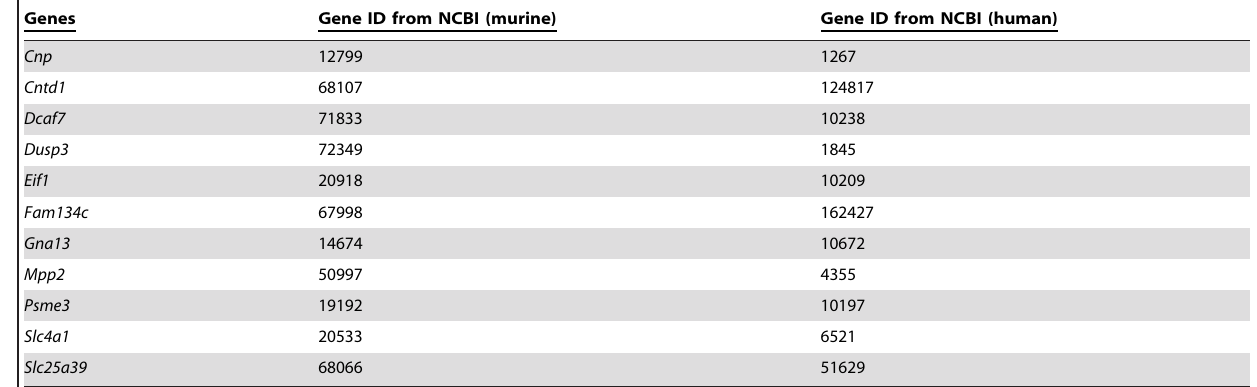
enhanced the production of TNF- a (p= 0.026) as compared with scrambled siRNA (Figure 5D and S8).